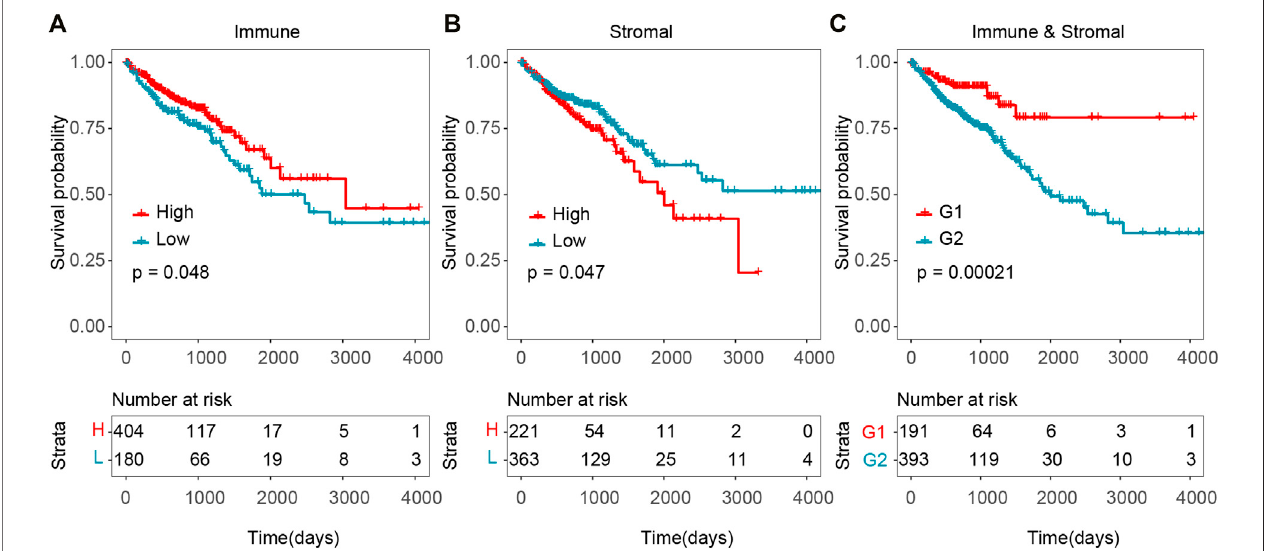
FIGURE 1 | Association between tumor microenvironment and overall survival time in TCGA CRC cohort. (A) Kaplan – Meier curves of high and low immune score groups. (B) Kaplan – Meiercurvesofhighandlowstromalscoregroups. (C) Kaplan – MeiercurvesofG1(highimmunescoreandlowstromalscoregroup) versus G2(low immune and stromal score group, high immune and stromal score group, low immune score and high stromal score group).